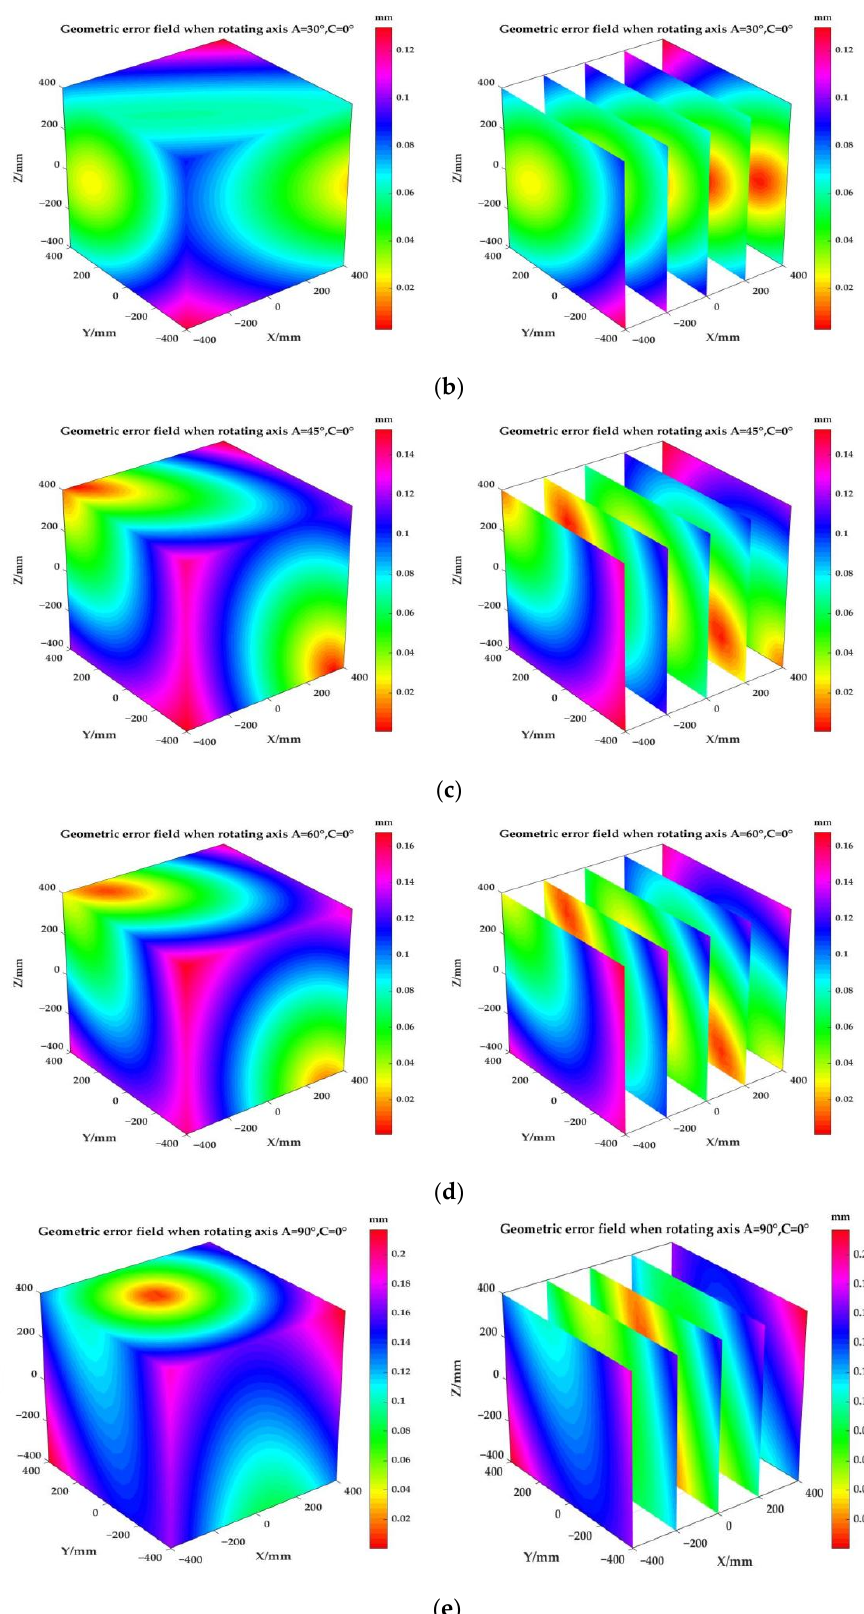
Figure 11. The distribution of the comprehensive error field at all angles of the A-axis at 0° C axis for ( a ) A = 0°, ( b ) A = 30°, ( c ) A = 45°, ( d ) A = 60°and ( e ) A = 90°. By analysing each error field, it can be seen that when A = 0°, as shown in Figure 11a, the rotation axis spatial comprehensive error of the five-axis CNC machine tool increases from the centre outwards. When the workspace is located near the origin of the ideal co- ordinate system on axes A and C, the synthetic errors are less than 4 μ m at all angles. When the workspace expands outwards, the synthesis error gradually increases, reaching a maximum of about 122 μ m at the edge of the workspace. In Figure 12b,c, when the ro- tation angle of the C-axis is less than 90° of the maximum comprehensive error range the C-axis rotation angle is increased. In Figure 12d, when the C-axis rotation angle reaches 90°, the comprehensive error maximum value reaches 234 μ m, and the minimum error also changes with the difference of the C-axis angle. It can be seen that the error caused by large rotation angles is also large. Therefore, in the cutting process, we should try to avoid excessive A-axis angle rotation, which can effectively reduce the influence of ma- chine tool geometric error on machining accuracy.